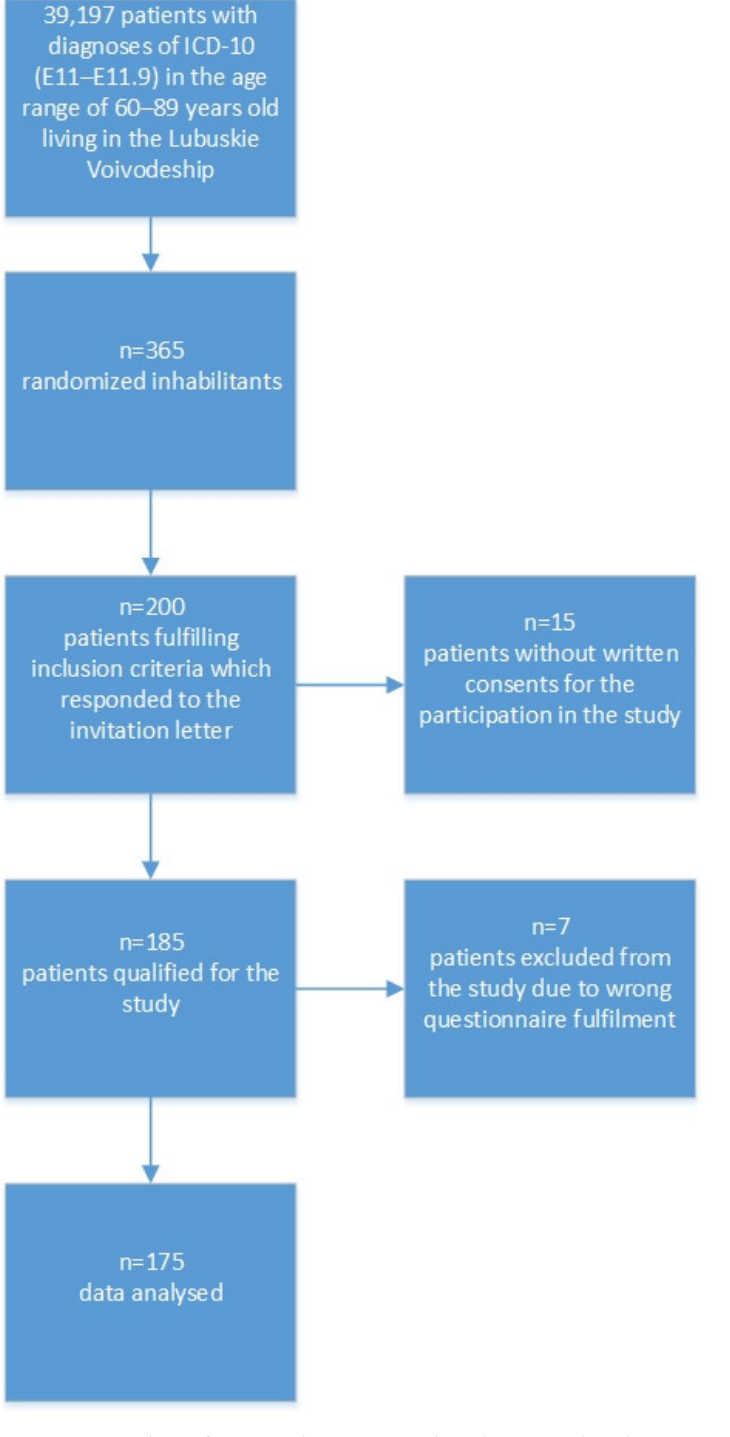
Figure 1. Sampling after considering research inclusion and exclusion criteria.